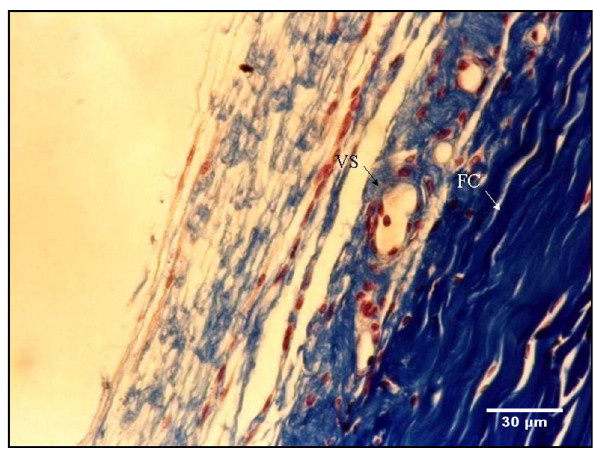
FIGURE 1 - Photomicrograph stained with Masson’s trichrome, showing concentration of collagen fibers (FC) and blood vessels (VS) in group G1 animals (malnourished and not treated, after 14 days). 400X magnification.